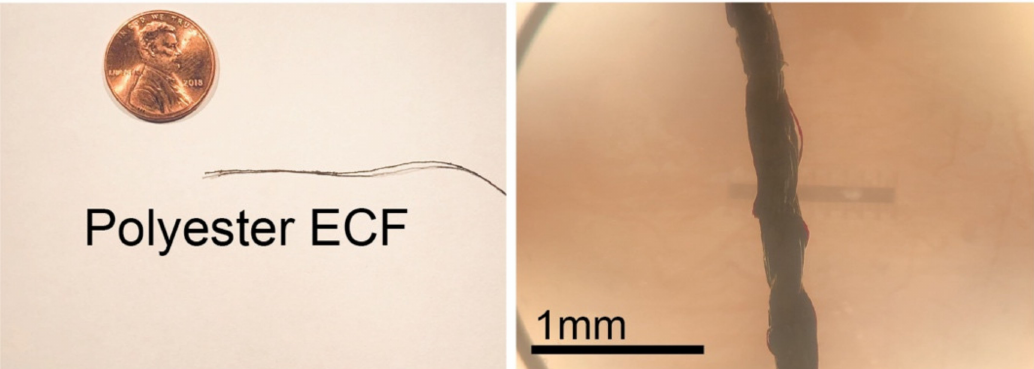
Figure 1. Macro ( left ) and microscopic image ( right ) of polyester-based ECF.